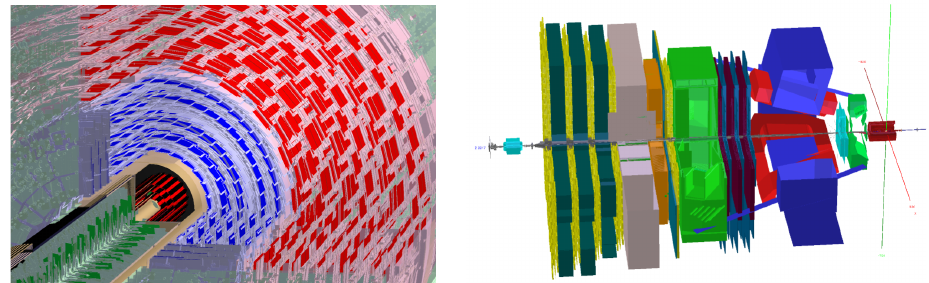
Figure 2. Left:Model of the CMS tracking system in DD4hep. Right: a model of the LHCb detector in